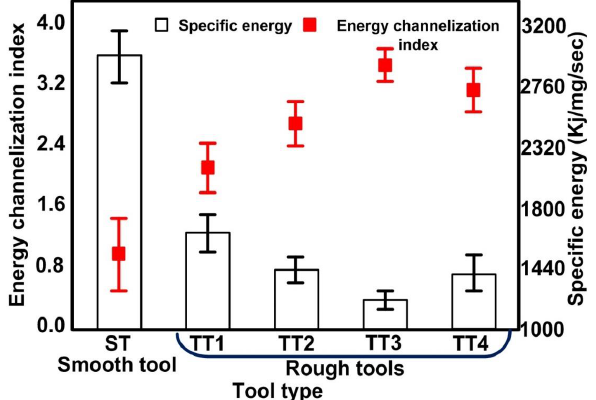
Figure 8. Effect of tool electrode topography on energy channelization index and specific